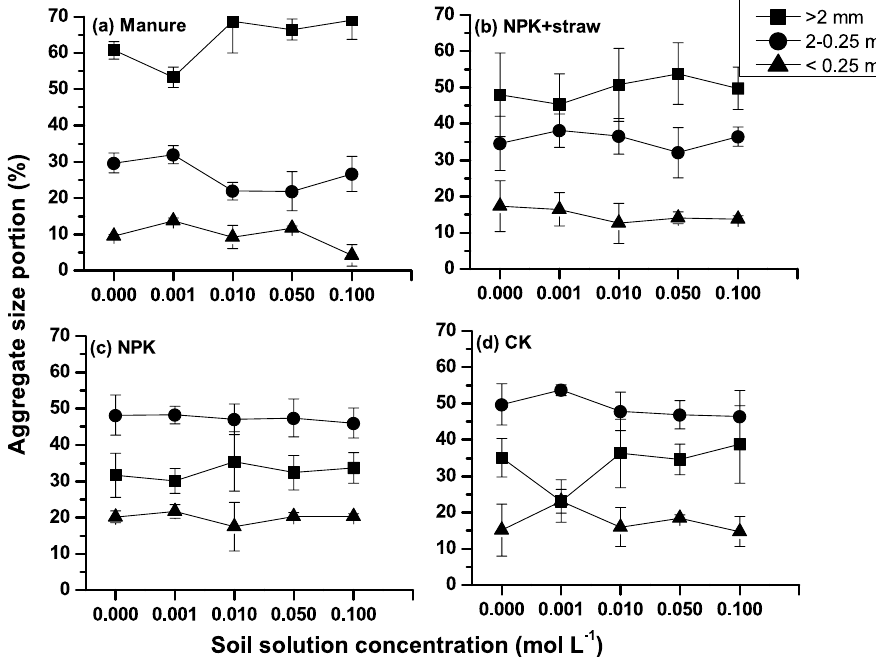
Figure 5. Aggregate size distribution with concentration over four types of fertilizations, including ( a ) Manure, ( b ) NPK + straw, ( c ) NPK, ( d ) CK.